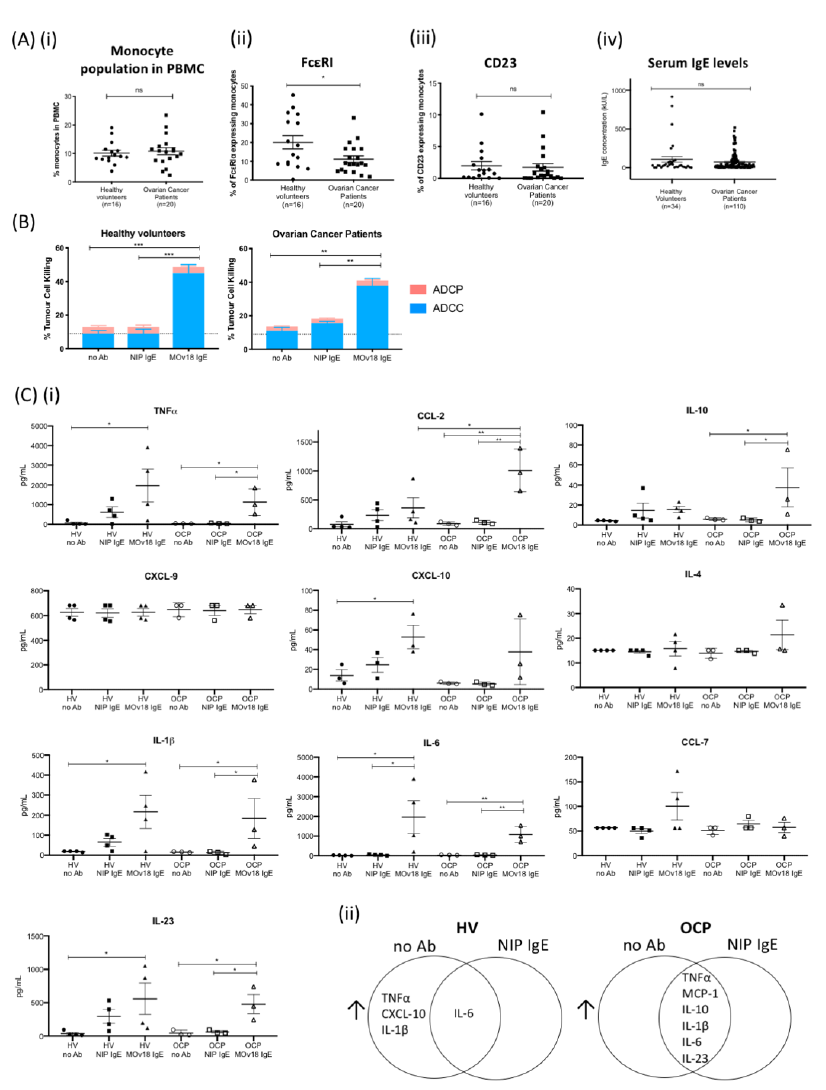
Figure 4. IgE potentiates cancer cell antibody-dependent cellular cytotoxicity (ADCC) and immune mediator release by monocytes from healthy volunteers and ovarian cancer patients. ( A ) (i) Proportions of monocytes within total PBMC of healthy volunteers and ovarian cancer patients. Comparison of (ii) FcεRI- and (iii) CD23-expressing monocyte proportions in healthy volunteers ( n = 16) and patients ( n = 20). (iv) Total serum IgE concentration measured in healthy volunteers ( n = 34) and patients with ovarian cancer ( n = 110). ( B ) MOv18 IgE potentiated in vitro killing of target IGROV1 ovarian cancer cells (compared with no antibody (no Ab) and isotype (NIP IgE) controls) by primary monocytes isolated from healthy volunteers (left, n = 4) and patients (right, n = 3) (independent experiments). ( C ) Cytokine and chemokine levels measured in cell culture supernatants from IgE-mediated ADCC/ADCP assays with primary monocytes (Luminex). (i) Quantitative analyses of immune mediators measured in the supernatants of ADCC/ADCP assays with monocytes from healthy volunteers (HV) ( n = 4) and from patients with ovarian cancer (OCP) ( n = 3) as effector cells (data from independent experiments). (ii) Venn diagrams of secreted mediators increased in supernatants from ADCC/ADCP assays with primary monocytes from healthy volunteers (left, n = 4) and from patients (right, n = 3) as effector cells: comparisons between MOv18 IgE treatment versus no antibody (no Ab) and MOv18 IgE treatment versus isotype NIP IgE controls (NIP IgE); upregulated cytokines by MOv18 IgE versus both NIP IgE and no Ab controls are shown for each human donor group. Error bars represent standard error of mean (SEM) of independent experiments. ( A ) A Student’s t -test and ( B , C ) one-way ANOVA with Tukey’s post-test were performed to assess significance (* p < 0.05; ** p < 0.01; *** p <